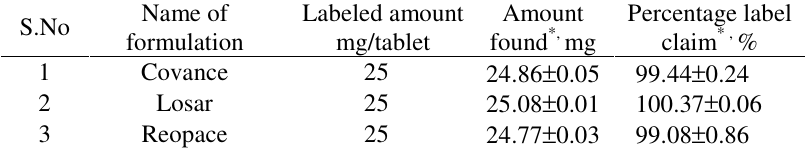
Table 1. Analysis of losartan potassium in formulation.